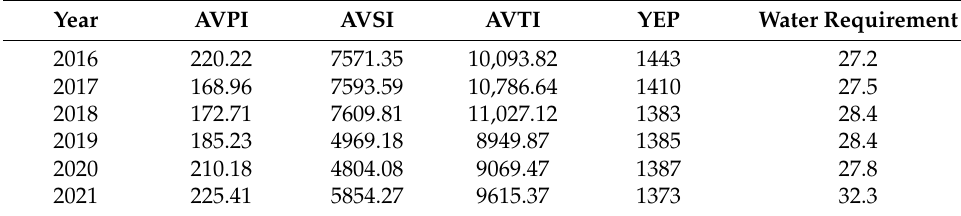
Table 3. The related data in Tianjin.